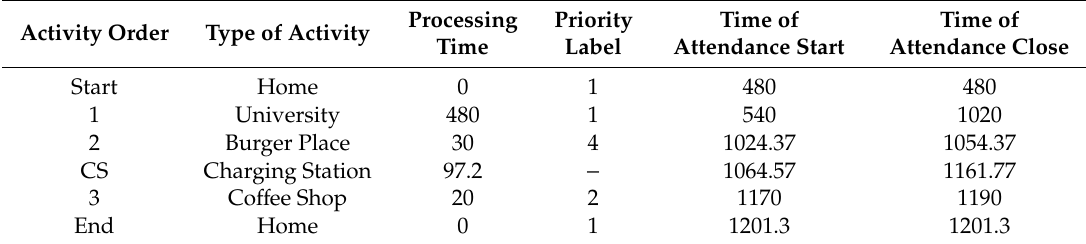
Table 8. Attributes of the solution regarding the visits to the